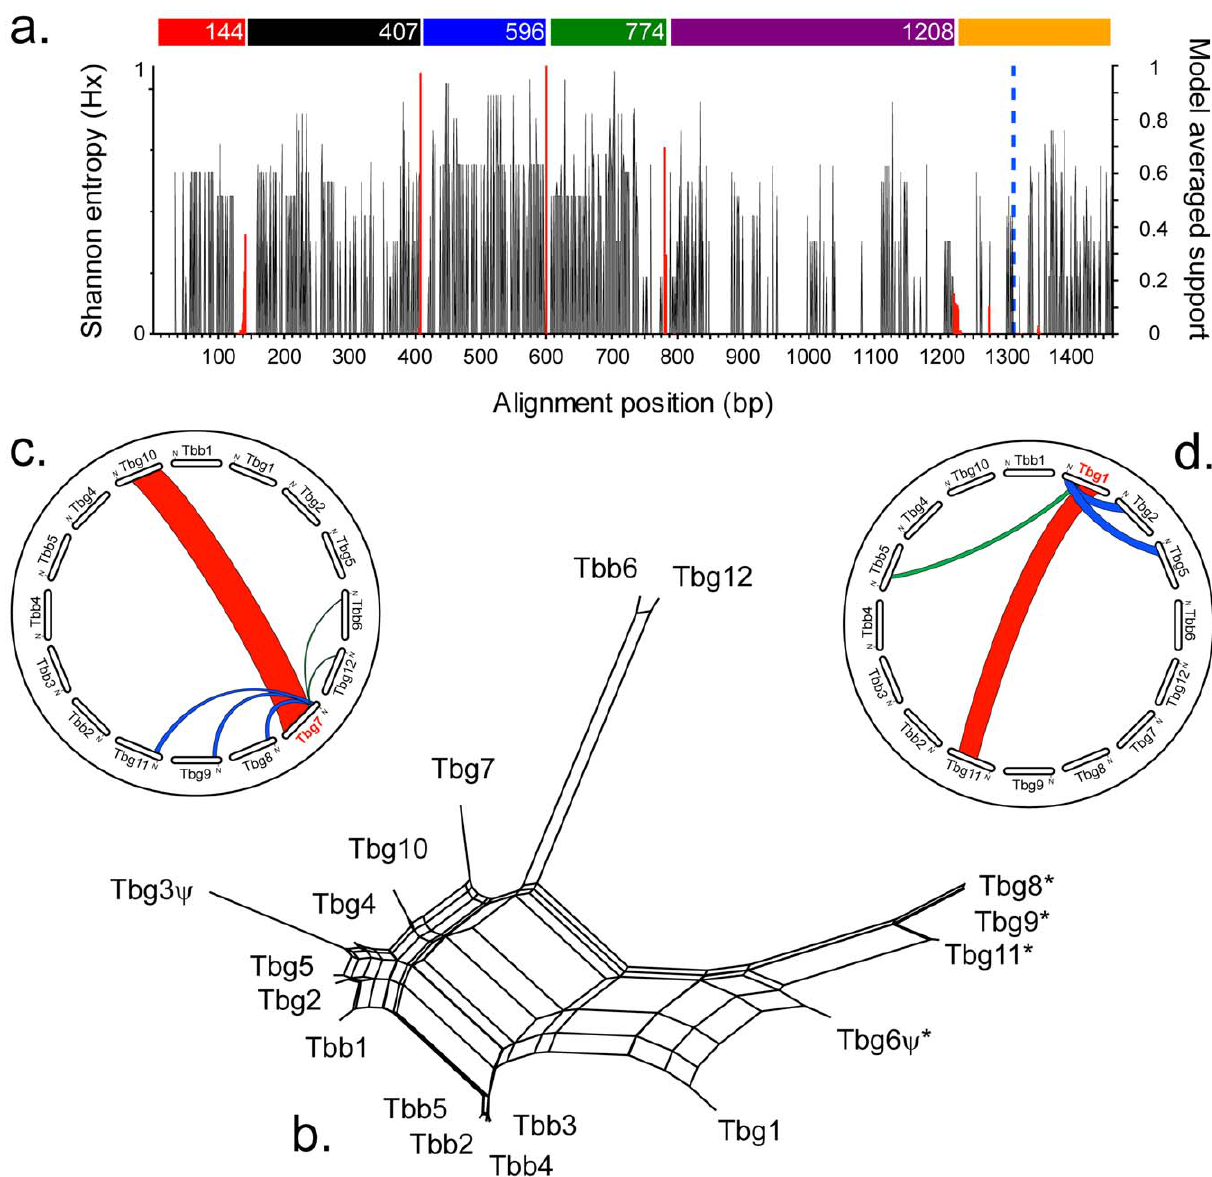
Figure 3. Analysis of sequence variation among T.brucei 65 kDa invariant surface glycoprotein genes. Gene copies are numbered consecutively in positional order from left to right on the chromosome, beginning with Tbb1 (Tb927.2.3270) and Tbg1 (Tbg972.2.1130) respectively. a . Sequence variation (expressed as Shannon entropy score, left scale) along a multiple sequence alignment, combined with recombination breakpoints (red lines, right scale) inferred by GARD analysis. A dotted blue line marks the boundary between coding and 3 9 UTR regions. Coloured bars above the chart indicate recombination tracts as identified by GARD. b . A phylogenetic network including sequences unique to one subspecies (marked with an asterisk *). Annotated pseudogenes are indicated by y . c . A chart showing the affinities of sequence Tbg7 only; all sequences are represented in a circle, coloured bars connect Tbg7 (or regions thereof) to its closest relative among other sequences. Different colours are used to denote different affinities. d . Affinity chart for